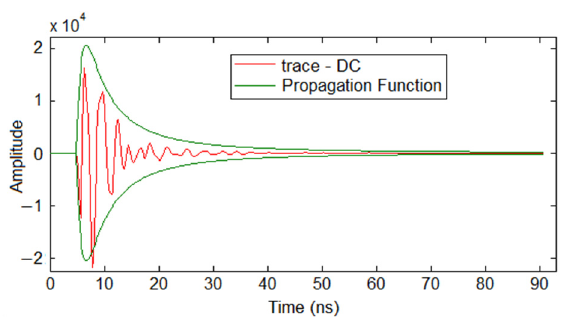
Figure 4. Propagation function (Equation (4)) applied to an example trace.